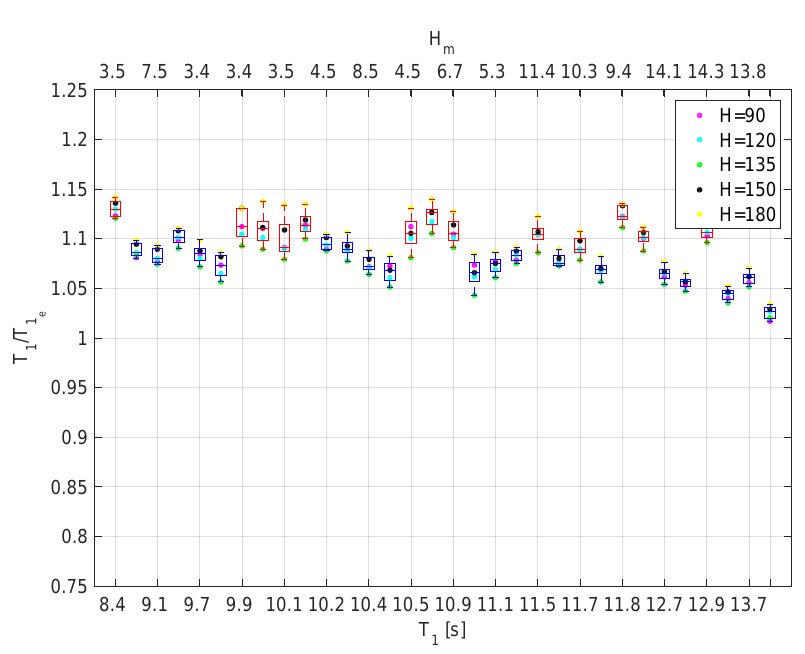
Figure 4. Box-plot showing the ratio between the estimated and measured mean wave period, obtained by means of the conventional approach.